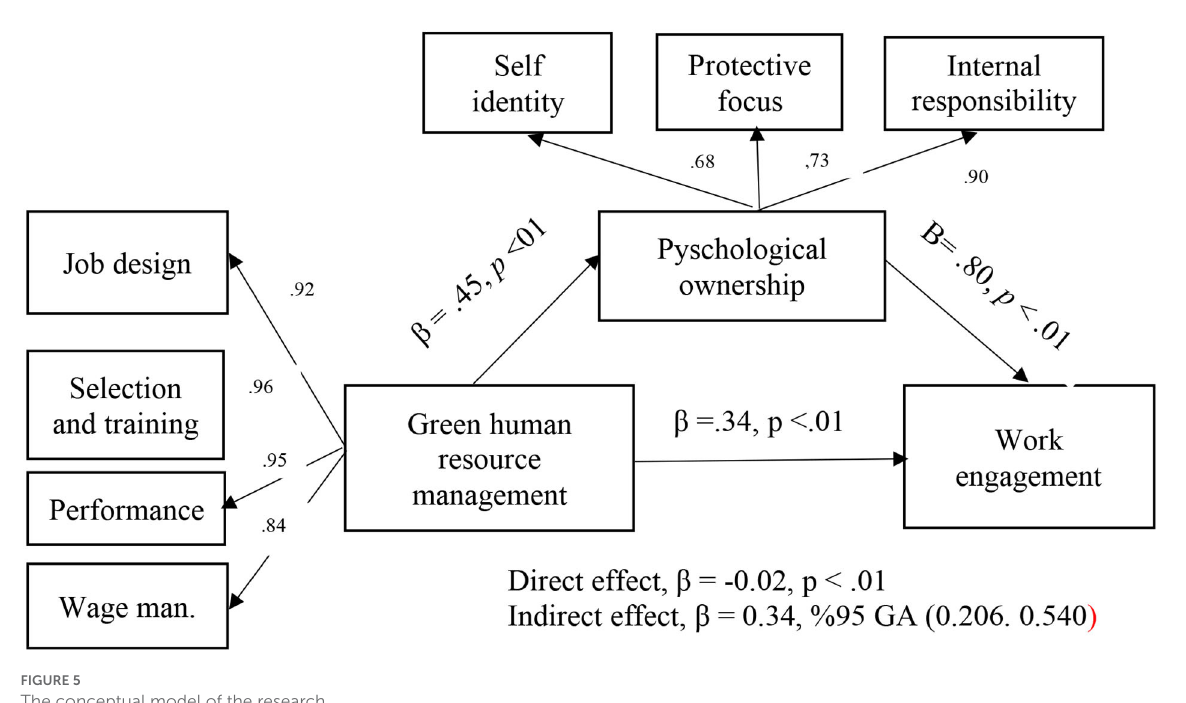
FIGURE5 The conceptual model of the research.